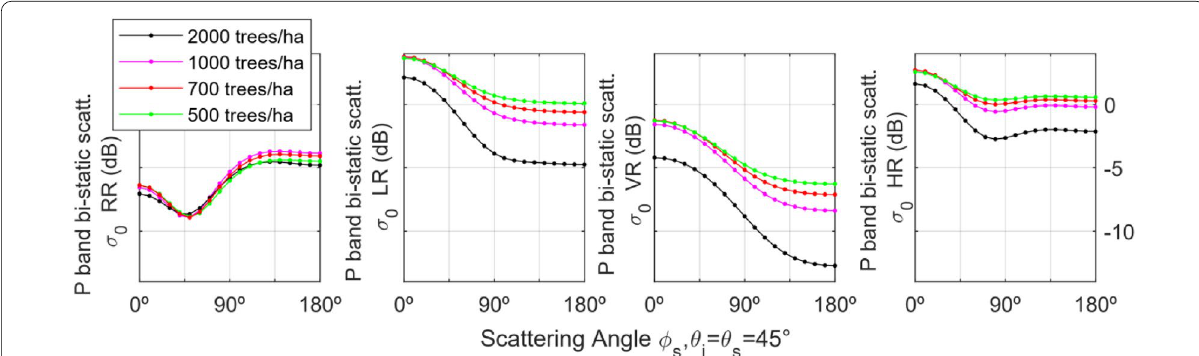
Fig. 12 P-band canopy bistatic scattering at different polarizations for 4 Aspen stands. The scattering geometry is the specular cone surface, θ i θ s = =